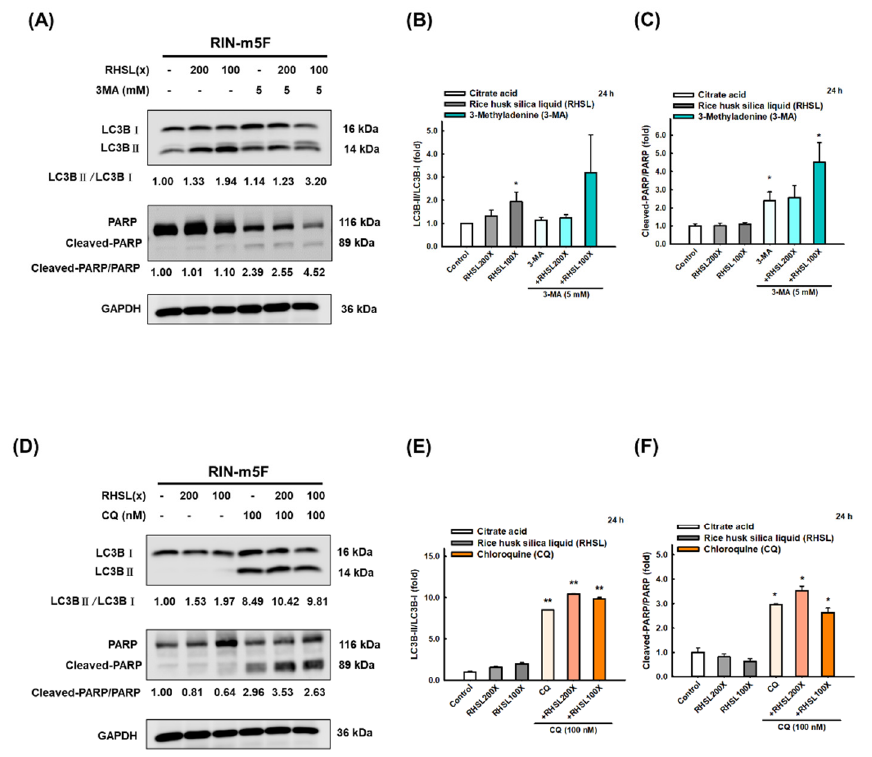
Figure 5. RHSL protects RIN-m5F cells from apoptosis through autophagy-induced. Following treatment with RHSL in the absence or presence of 3-MA (5 mM, A ) and CQ (100 nM, D ) for 24 h. Representative immunoblot for quantification of LC3B ( B , E ) and cleaved-PARP ( C , F ) expression in RIN-m5F. The optical densities of bands in each lane were normalized to GAPDH (loading control) optical density from the same gel. * p < 0.05; ** p < 0.001 compare with each control group (citrate acid).